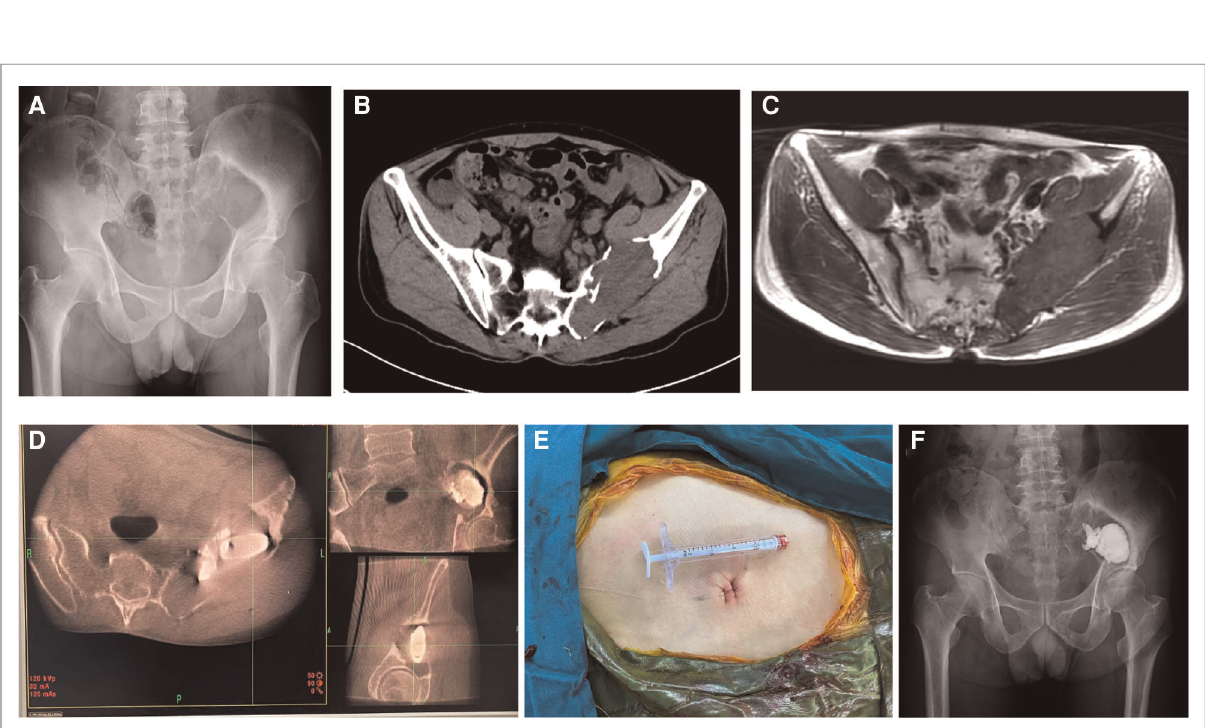
FIGURE 1 55-year-old man with metastatic renal cell carcinoma and a painful pelvic metastasis. ( A ) Preoperative pelvic x-ray. ( B,C ) Preoperative pelvic CT and MRI scans. ( D ) Intraoperative O-arm 3D image during puncture and cementoplasty. ( E ) Skin incision. ( F ) Postoperative pelvic x-ray 6 months after the